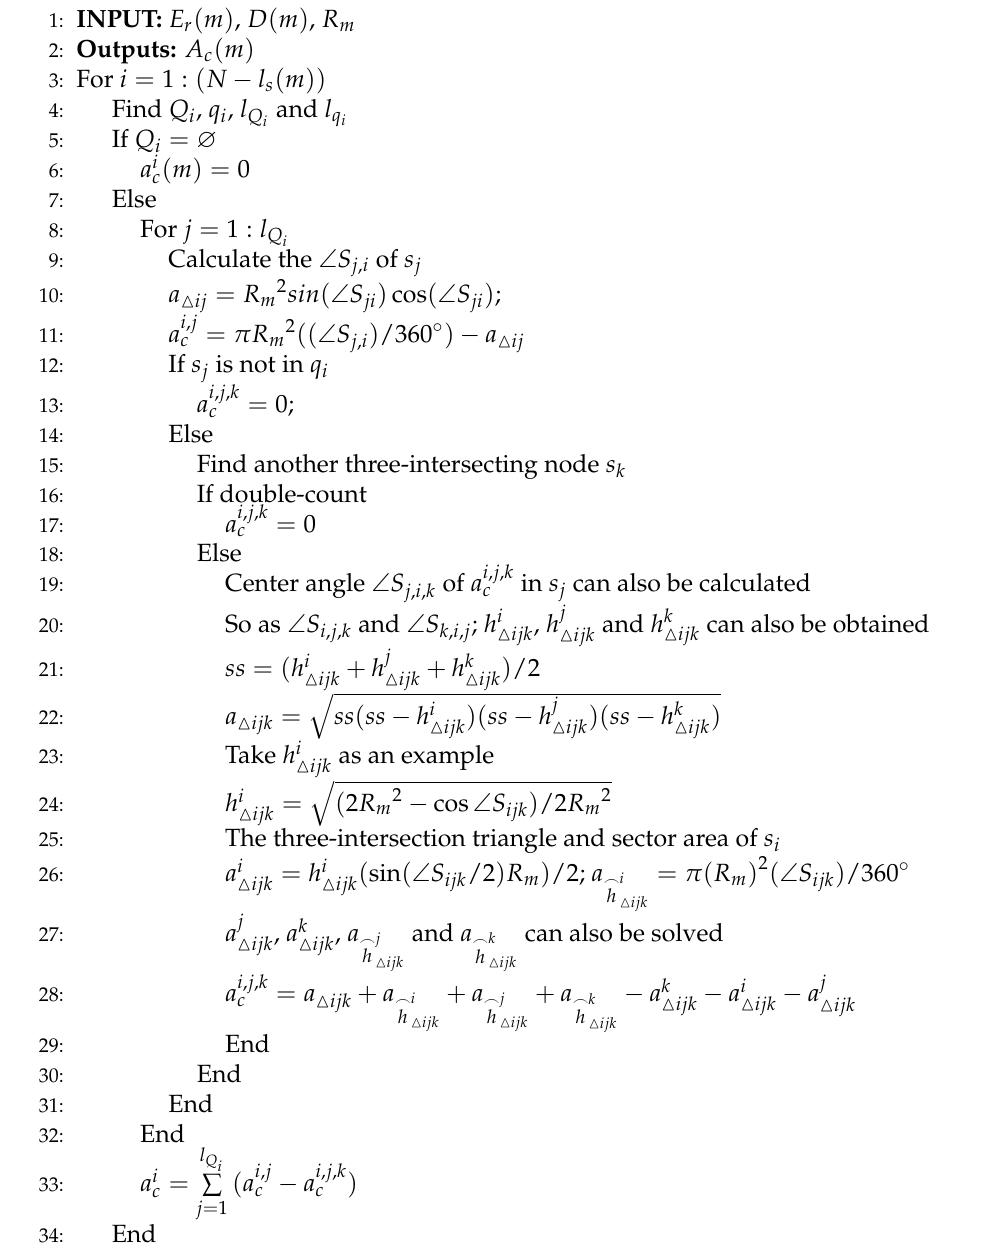
Algorithm 1 Real-time AoCS